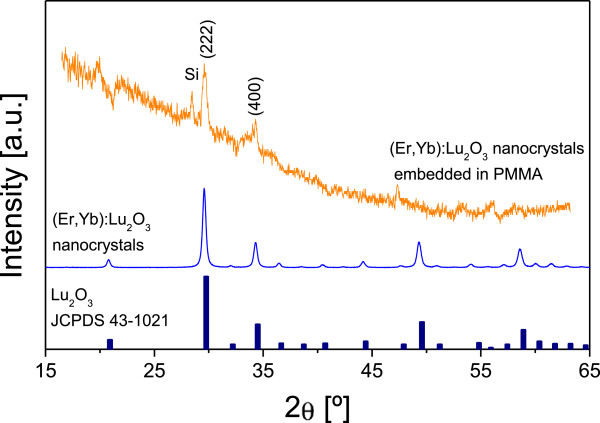
XRD pattern of (Er,Yb):Lu2O3 immersed in PMMA and (Er,Yb):Lu2O3 nanocrystals and JCPDS 43–1021 as reference pattern.